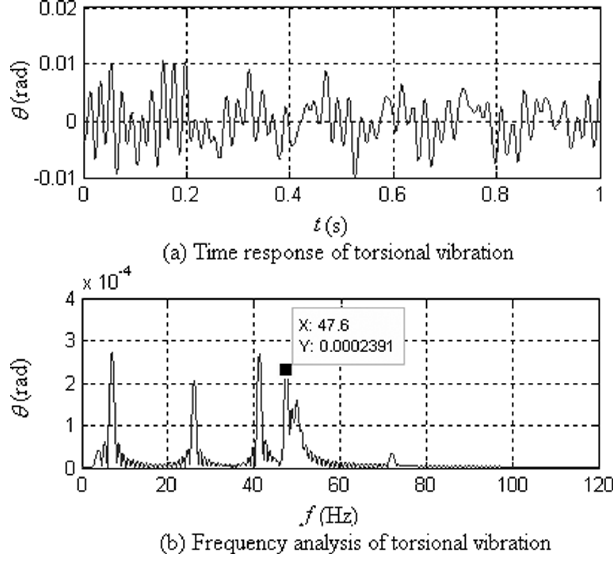
Fig. 7. Response and frequency analysis of the torsional vibration under the three-phase short-circuit.